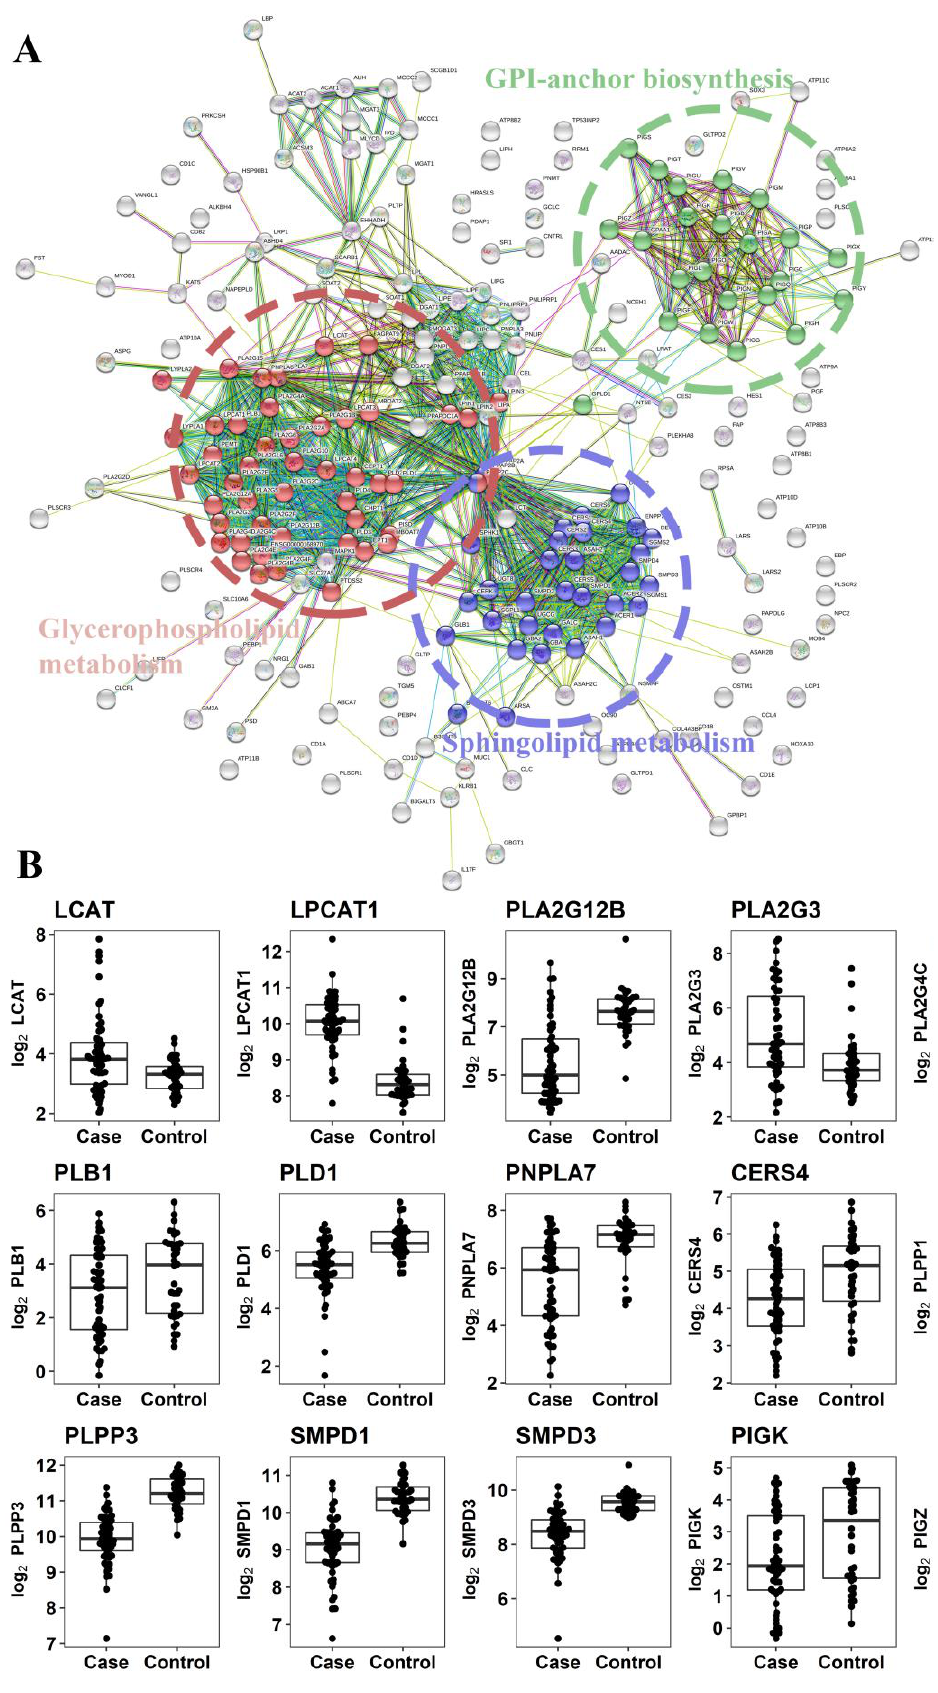
Figure 4. Gene networks of enzymes related with metabolism of stool CRC-altered lipids. Three major pathways could be observed: Sphingolipid and glycerophospholipid metabolisms, and GPI-anchor biosynthesis ( A ). Gene expression in silico analysis of CRC tumoral tissue. The expression of gene-